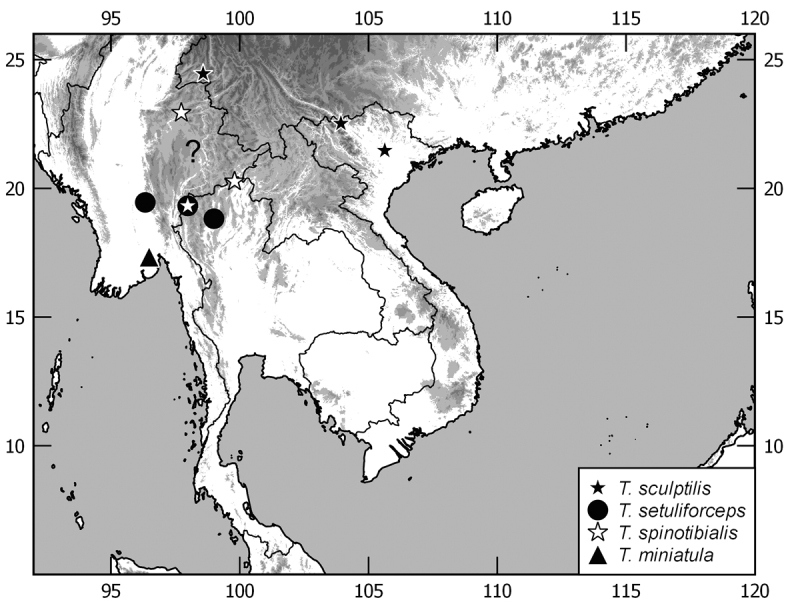
Distribution map of Tetrasericagiulianae sp. n. (? – not located exactly in Shan state), T.miniatula (Moser), T.sculptilis Liu et al., 2014, T.setuliforceps sp. n., T.spinotibialis sp. n.